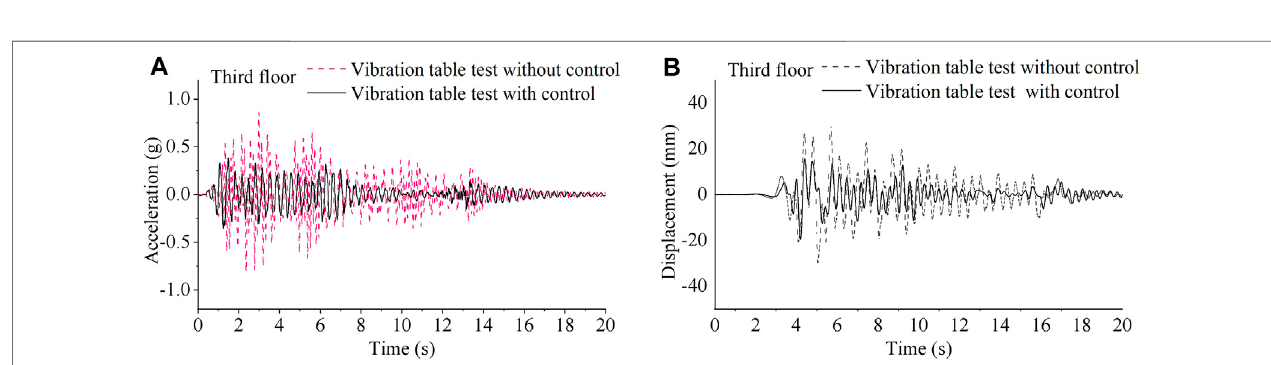
FIGURE 7 | Time history curve of displacement response and acceleration response on experimental model structure in vibration table test: (A) acceleration response on the third fl oor, and (B) displacement response on the third fl oor.